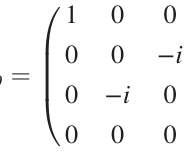
FIG. 13. Residual error per gate ϵ the bond dimension χ for the 2D circuit of Fig. 12 for a depth D ¼ 20 . The different curves correspond to different groupings. The horizontal dashed line corresponds to the error rate asso- ciated with a global fidelity F ¼ 0 . 002